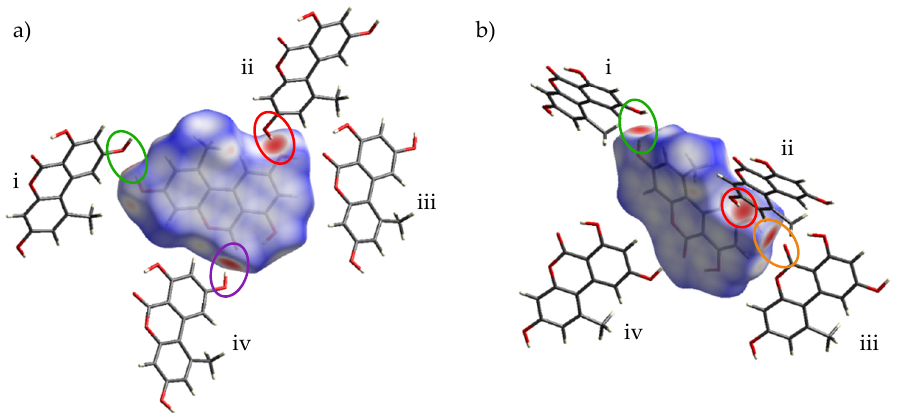
Figure 6. Hirshfeld surface of Form I mapped over d norm along with external molecules i–iv: a perpendicular view of the molecule and its surface ( a ) and an angled view ( b ). Red regions on the surface represent close contacts, blue regions represent long contacts, and white regions represent contacts in which the distance is equal to the sum of van der Waals radii.